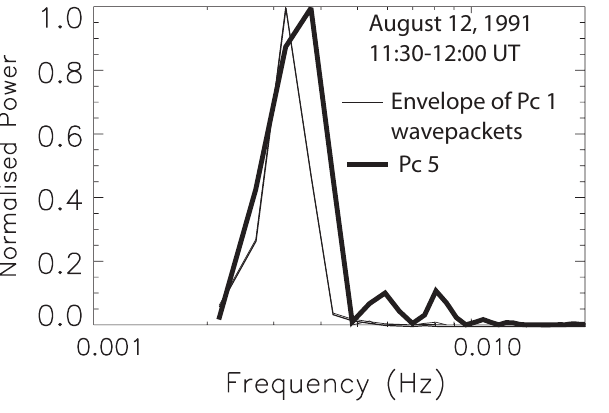
Fig. 3. Orbit 926, 12 August 1991 normalised power spectra over the interval 11:30–12:00UT. The thinline is the Pc 1 transverse wave amplitude envelope spectrum while the thickline is the Pc 5 wave